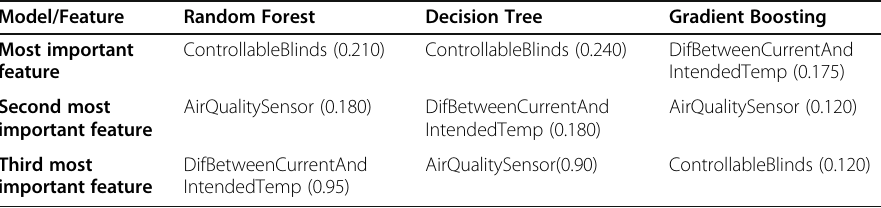
Table 4 The three most important features of classification models Model/Feature Random Forest Decision